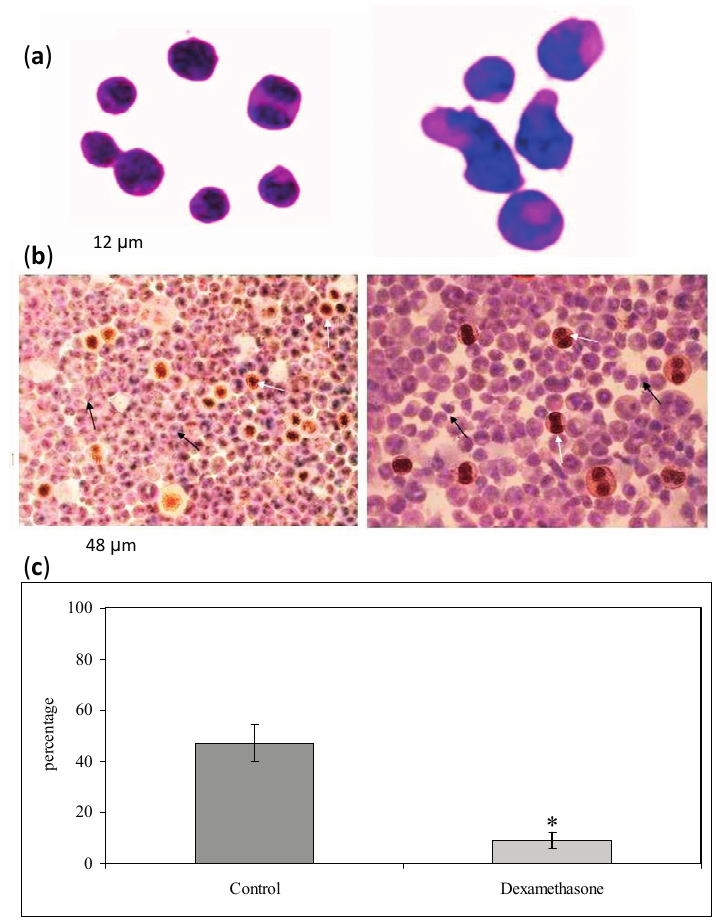
Figure 4. Effect of Dexamethasone on Cell Morphology and B-cell lymphoma-2 (Bcl-2) expression. The image analysis of morphology and Bcl-2 positivity was performed by using inverted microscopy EUROMEX FE 2935 (ED Amhem, The Netherlands) equipped with a CMEX 5000 camera system. ( a ) Rappresentative example of cells cultured in the absence (C = control) or in the presence of Dex for 48 h. Hematoxylin-eosin staining, 40× magnification. The images were highly contrasted to cancel the background and highlight the characteristics of the cells; ( b ) Immunohystochemical analysis Bcl-2. The cells were analyzed after 48 h of culture in the absence (C) or presence of Dex. White arrows indicate examples of normal (C) or apoptotic (Dex) cells, black arrows indicate Bcl-2 positive cells (10× magnification); ( c ) The intensity of immunostaining was evaluated. The findings were classified as follows: ( − ), no reactive cells; (+), low positive cells; (2+), medium positive cells; (3+), strong positive cells. Only the 3+ cells, with intense immunostaining, were considered for quantification. The data are expressed as percentage of total cells that resulted Bcl-2 3+ positive and represent the mean ± S.D. of 3 independent experiments performed in duplicate. (Significance, * p < 0.001 versus control